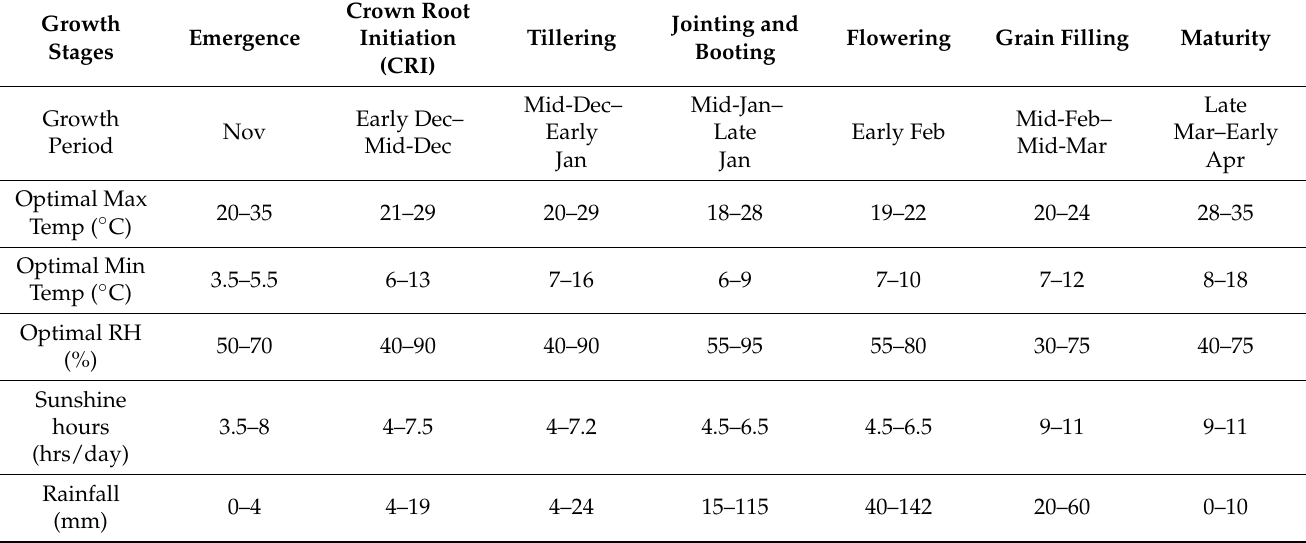
Table 7. Sensitivity of crop growth stages to weather variables—specific to study